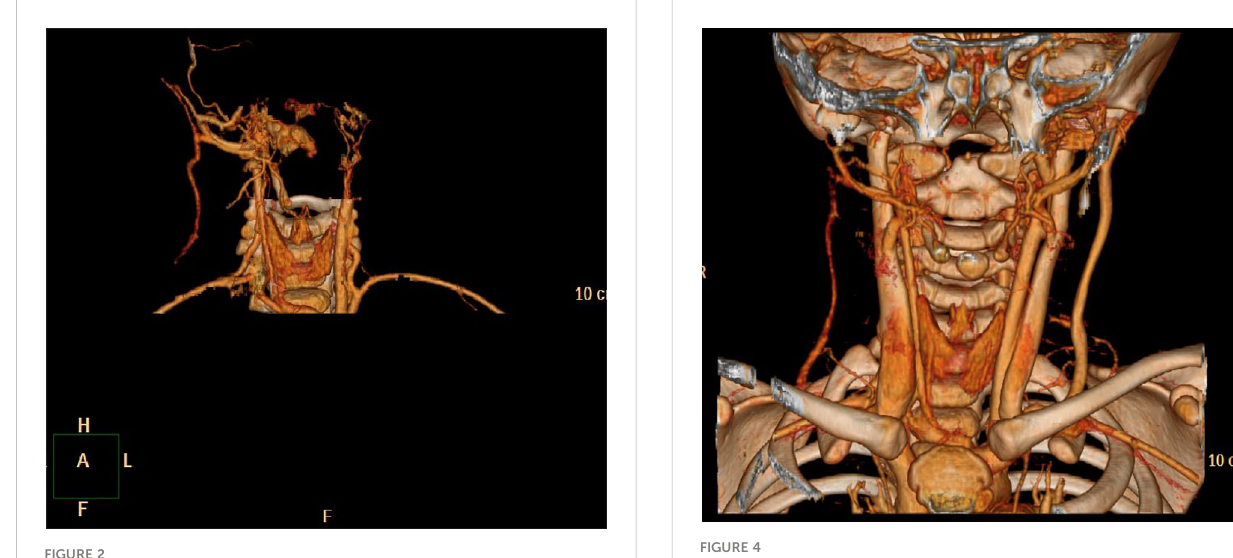
FIGURE 2 No. 8 patient 3D reconstruction of subacoustic hemangioma before treatment.